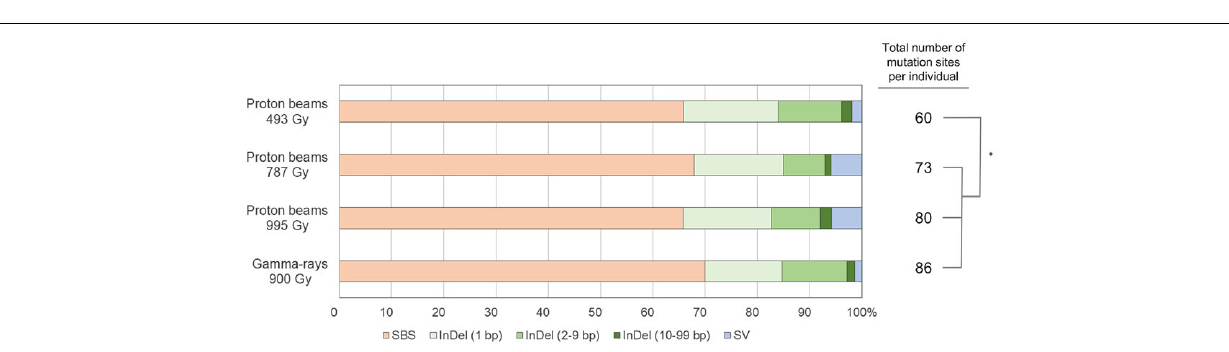
SBSs in P494 was significantly lower than those in the other three groups, and no significant difference was detected among those in the three groups ( Figure 5A ). The frequency of homozygous SBSs was highest in G900, followed by P995, P787, and P494